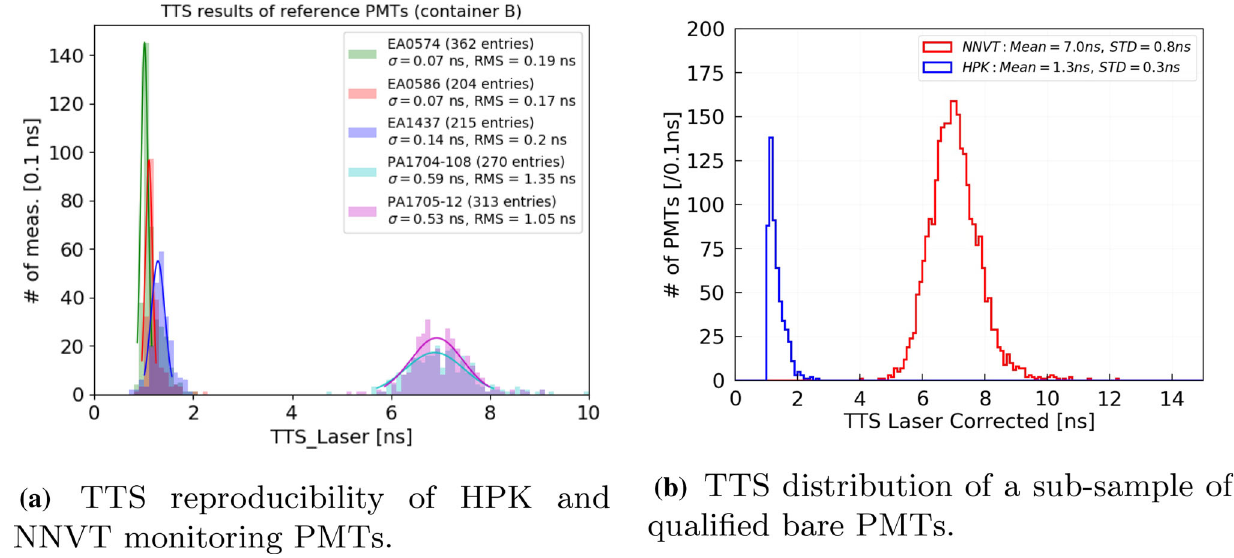
Fig. 26 Left: TTS results of the monitoring PMTs in container #B. Combined result distribution of all monitoring PMTs (3 HPK, 2 NNVT, testedinallchannels)showsagoodreproducibilityoftheresults.Right: